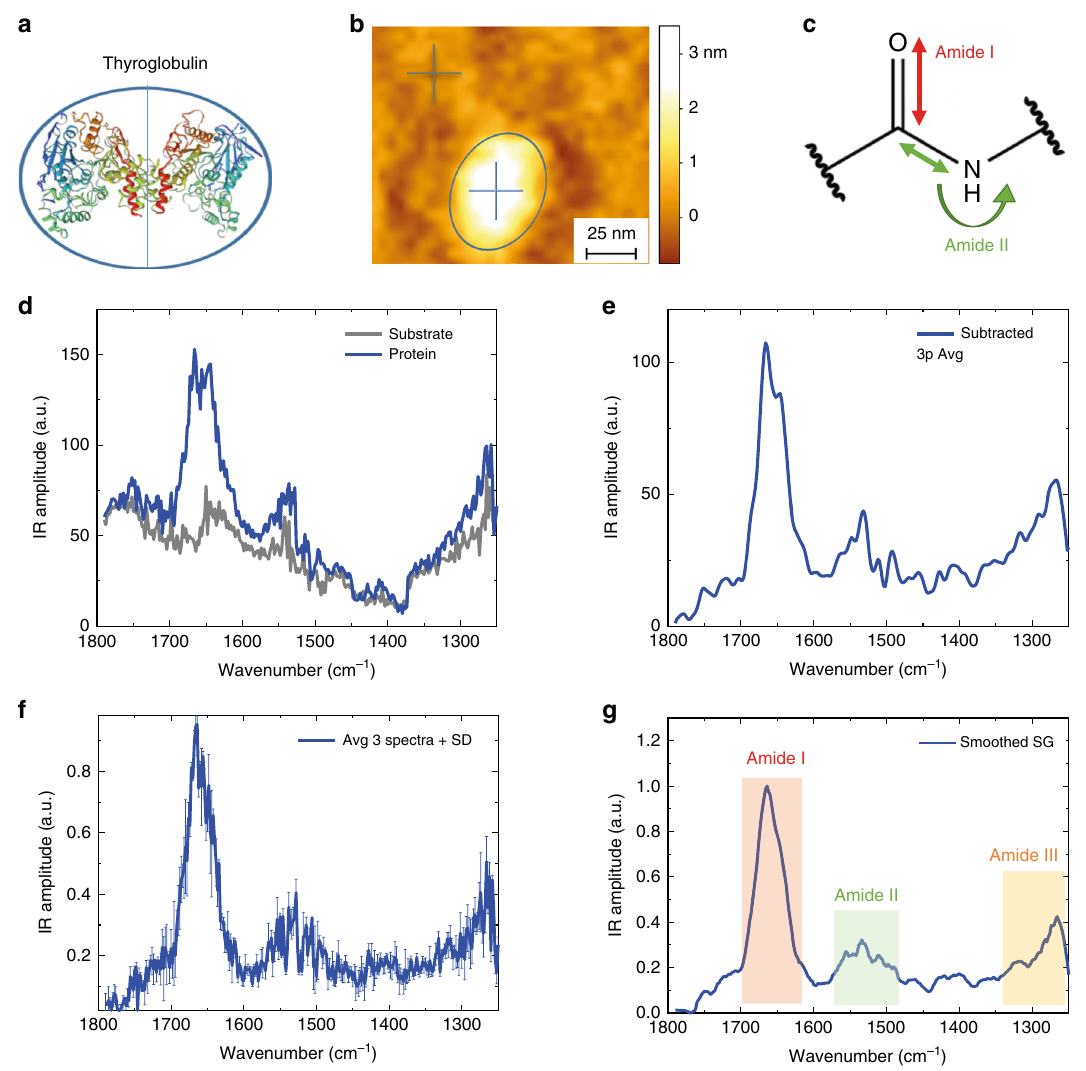
Fig. 3 ORS-nanoIR absorption spectra of single protein molecules. a Thyroglobulin structure 29 . b Morphology map of a single protein (blue circle). c Schematic of the chemical bond vibration leading to the amide band I (80% C = O stretching, 10% C – N stretching; 10% N – H bending), amide band II (60% N – H bending and 40% C – N stretching) 19 . d IR absorption spectra acquired on the protein (blue cross), on gold (grey cross) (laser power: 0.3 mW; pulse: 60 ns). e Protein – substrate subtraction spectrum with adjacent averaging of three points. f Average of three different subtracted spectra on the same protein with standard error. g Savitzky – Golay smoothed (second order, 13 pt) and baselined spectrum in amide bands I, II, III. The error bars represent the average + s.d. Source data are provided as a Source Data fi